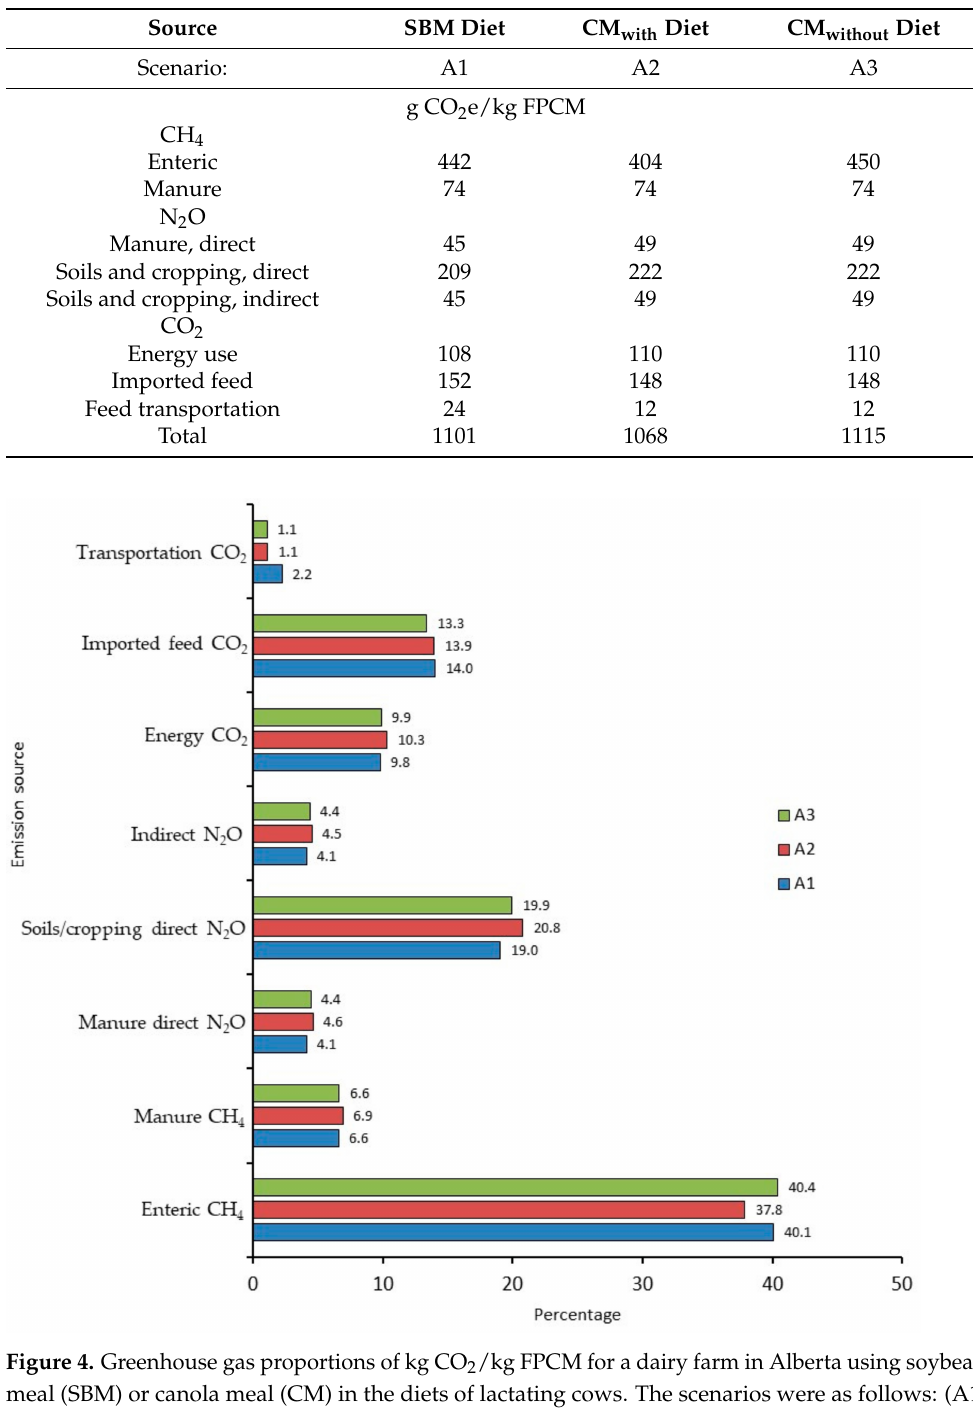
Table 9. Greenhouse gas emission intensity of fat and protein corrected milk (FPCM) produced by a dairy farm in Alberta using soybean meal (SBM) or canola meal, with (CM with ) and without (CM without ) enteric methane mitigating effect, in the diets of the lactating cows.